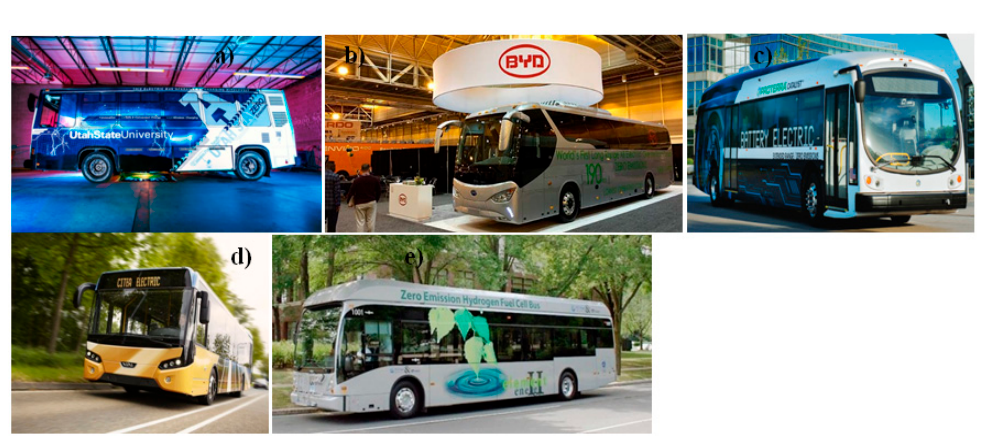
Figure 2. Electric/hybrid Buses; ( a ) Aggie Bus of Utah State; ( b ) BYD C9 Bus; ( c ) Terra Volt Bus; ( d ) CCs Bus; ( e ) Siemens Fuel Cell Bus.